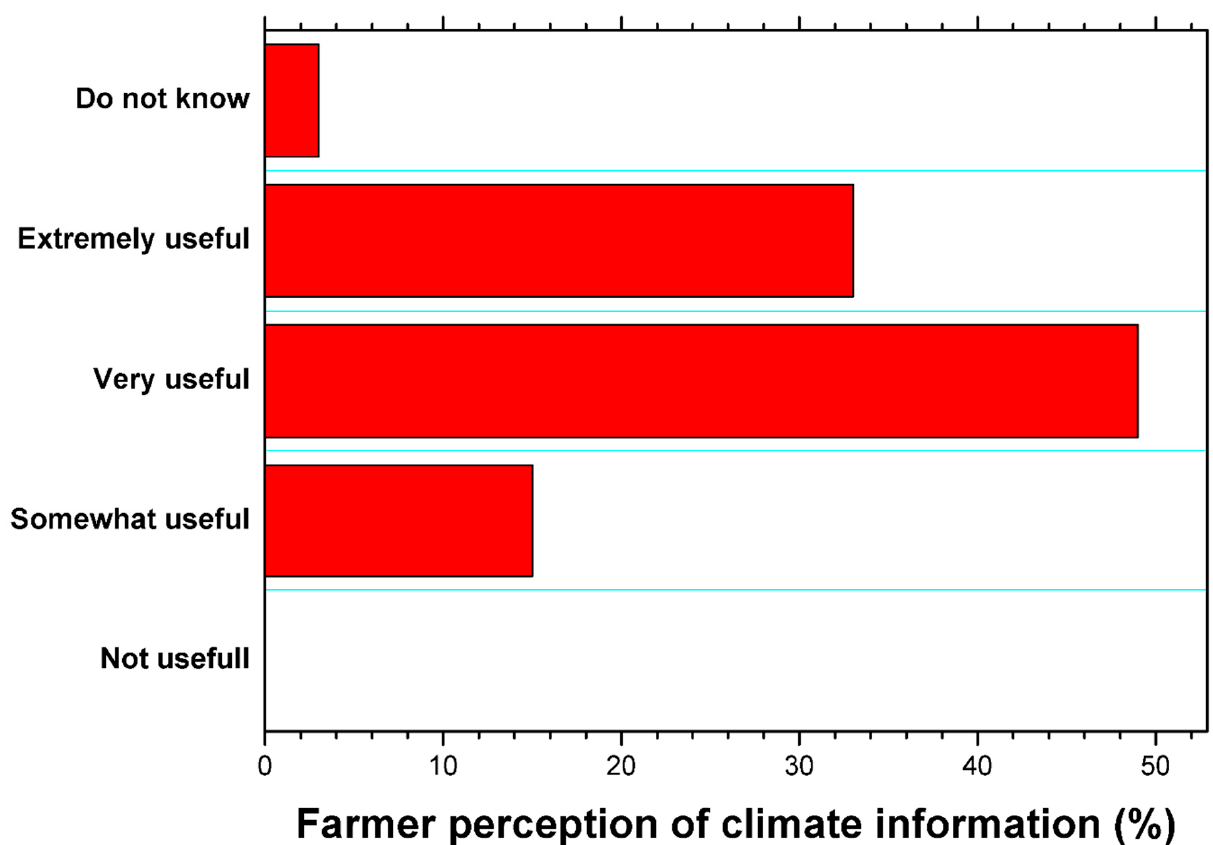
Figure 3. Small scale farmer perception of the importance of climate information for disaster preparedness in the cereal value chain.